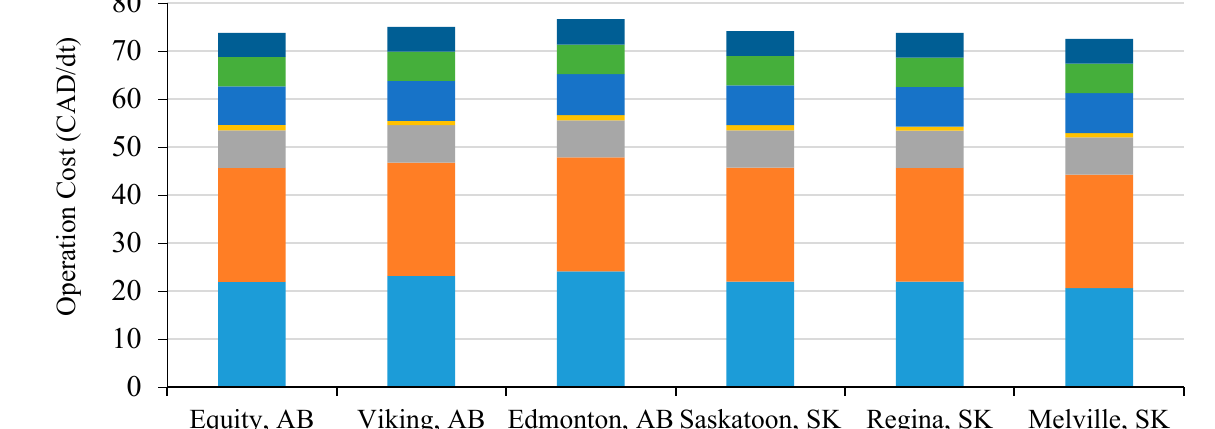
Figure 7. Biomass logistics costs for the six case studies.